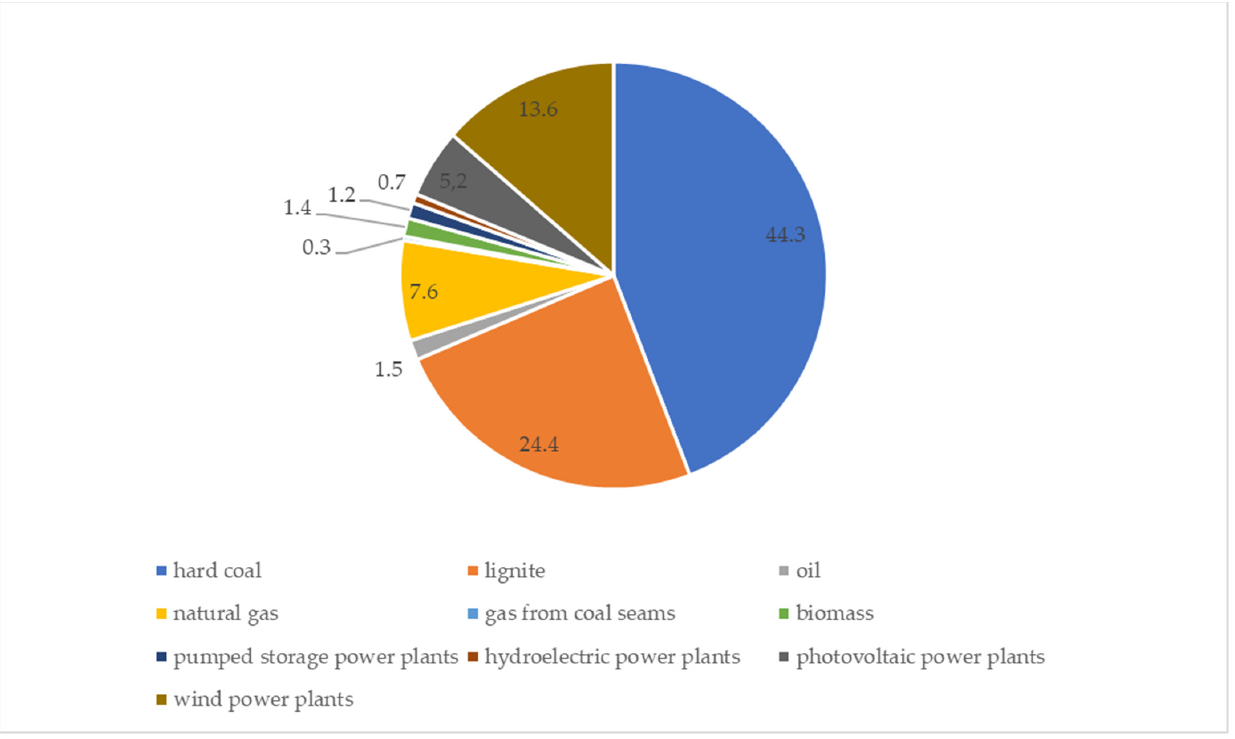
Table 3. Results of the multiple regression analysis investigating the relationship between the dependent variable Y 1 (electricity production from renewable energy sources) and the explanatory variables.